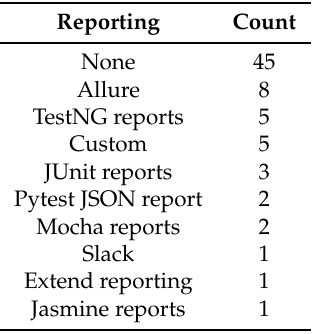
Table A16. 5.c. What kind of reporting do you get from your Selenium tests?